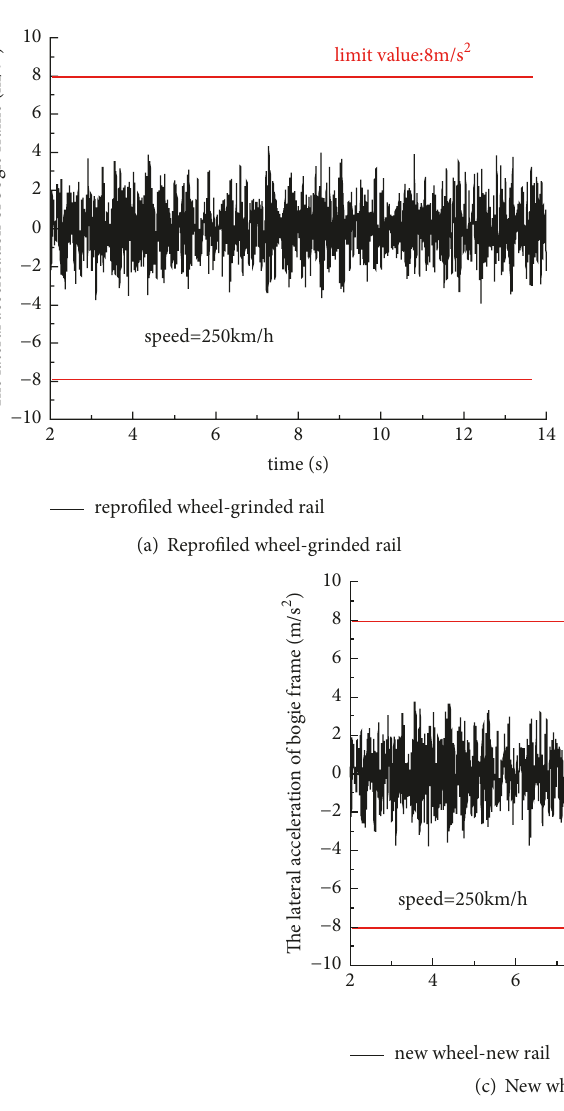
Figure 13: The lateral acceleration of bogie